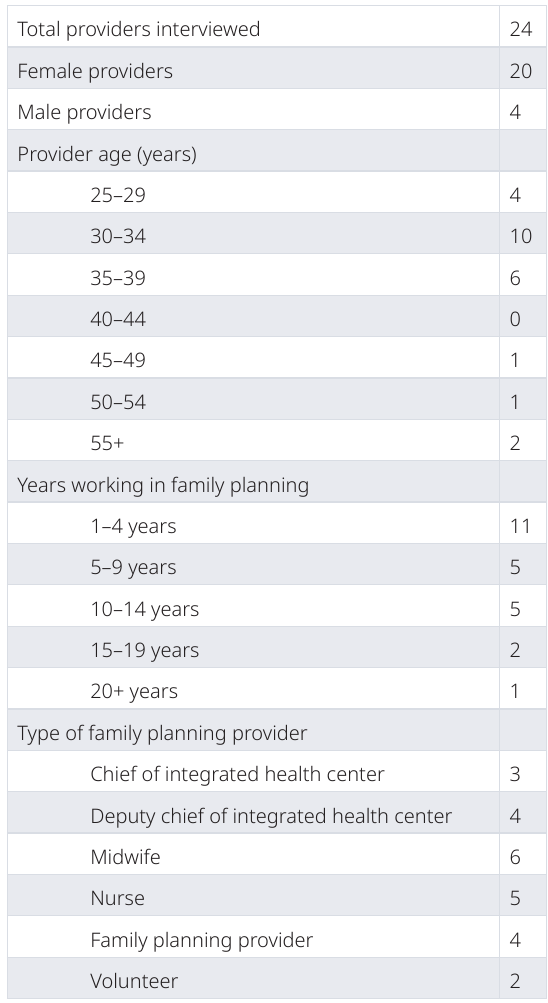
Table 1. Provider